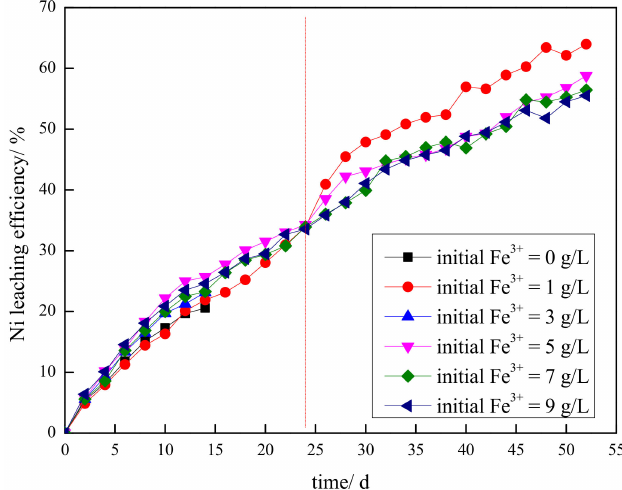
Figure 4. Changes in the Ni leaching e ffi ciency with